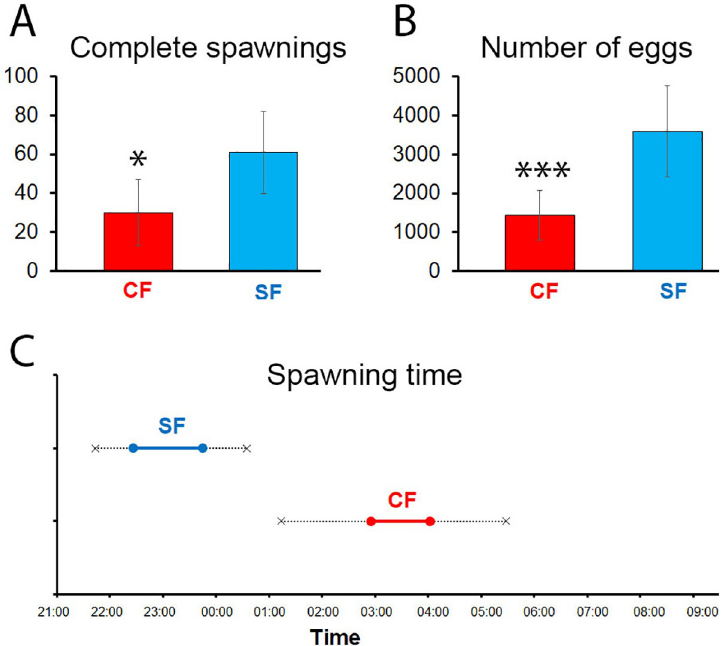
Fig 3. Quantification of spawning behavior, per spawning period and per female, in A . mexicanus . A, comparison of the number of completed spawning sequences in surface fish females (SF, blue; n = 6) and cavefish females (CF, red; n = 7) during a spawning period. Results are presented as mean ± SD. B, comparison of the estimation of the number of eggs produced by surface fish females (SF, blue) and cavefish females (CF, red) during a spawning period. C, comparison of the spawning time during the night in surface fish (SF, blue) and cavefish (CF, red).